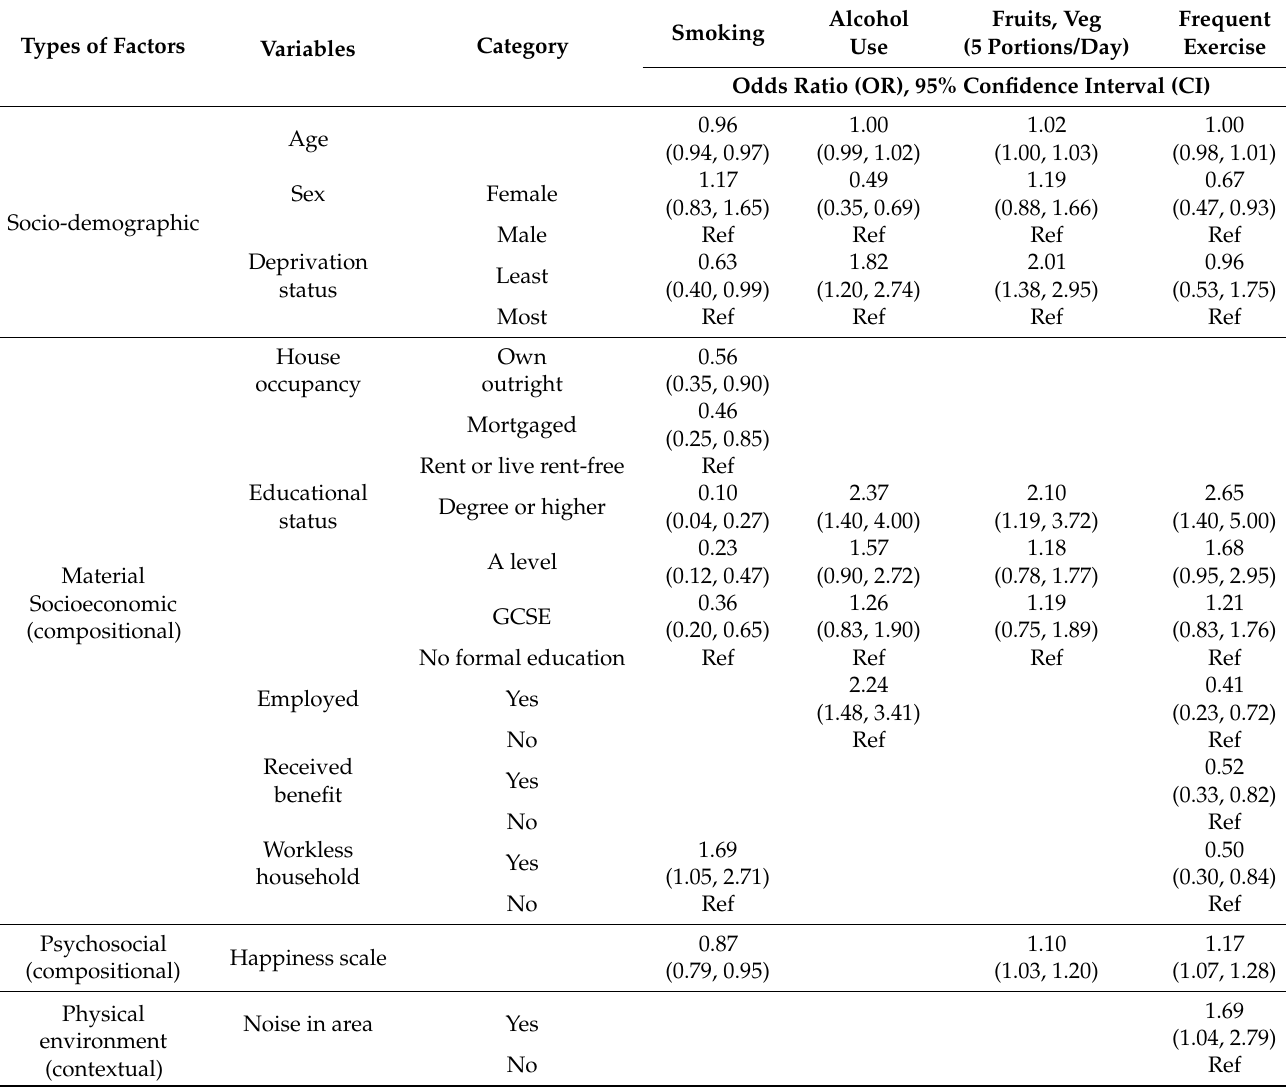
Table 3. Factors associated with smoking, alcohol use, consumption of five fruits and vegetables/day, frequent exercise, adjusted for clusters, age, gender and